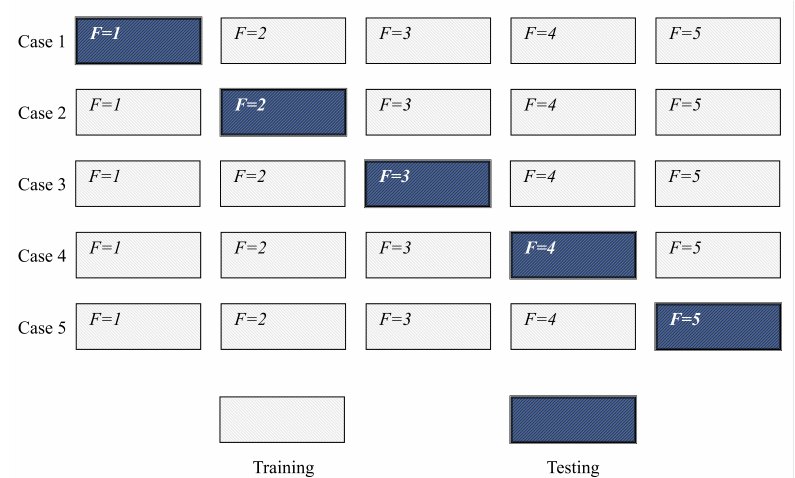
Figure 10. A schematic representation of the five-fold cross-validation